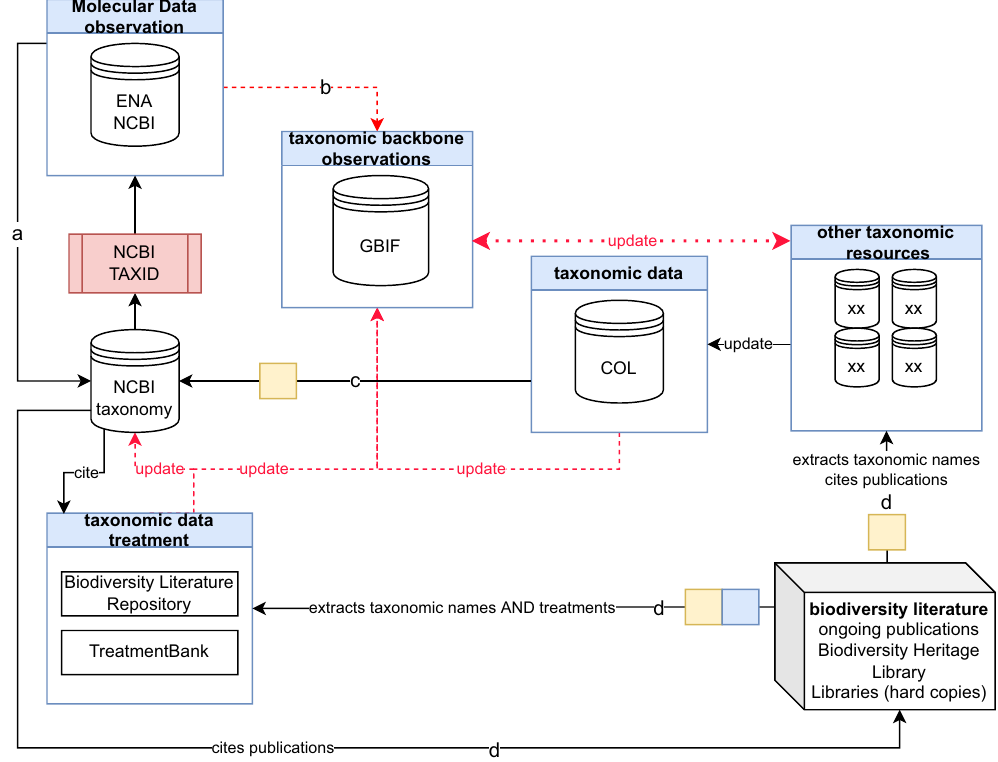
Figure 1. Interconnections of taxonomy and molecular data resources. A schematic representation of the primary molecular and taxonomy data resources illustrating how they are interconnected to support the develop- ment of comprehensive taxonomies linked with unique taxonomic identifiers (taxID). Specifically, each NCBI taxID isassociatedwithamolecularsequencein(a)theNCBIandENAprimarydatabaseswhichfeed(b)theGBIFtaxonomy backbone. (c) COL informs both the NCBI taxonomy and GBIF with new or updated taxa names taking information from third party specialised resources. Finally, (d) literature data are used to extract taxonomic names and treatments to enhance and update NCBI taxonomy, GBIF and COL through the Biodiversity Literature Repository and TreatmentBank. ‘ XX ’ indicates taxon or other specialised resources. Lines with arrows indicate data sharing efforts. Dashed lines with red arrows indicate that only a part of data is shared with the destination resources. Blue boxeshighlightmachineannotationandyellowboxes